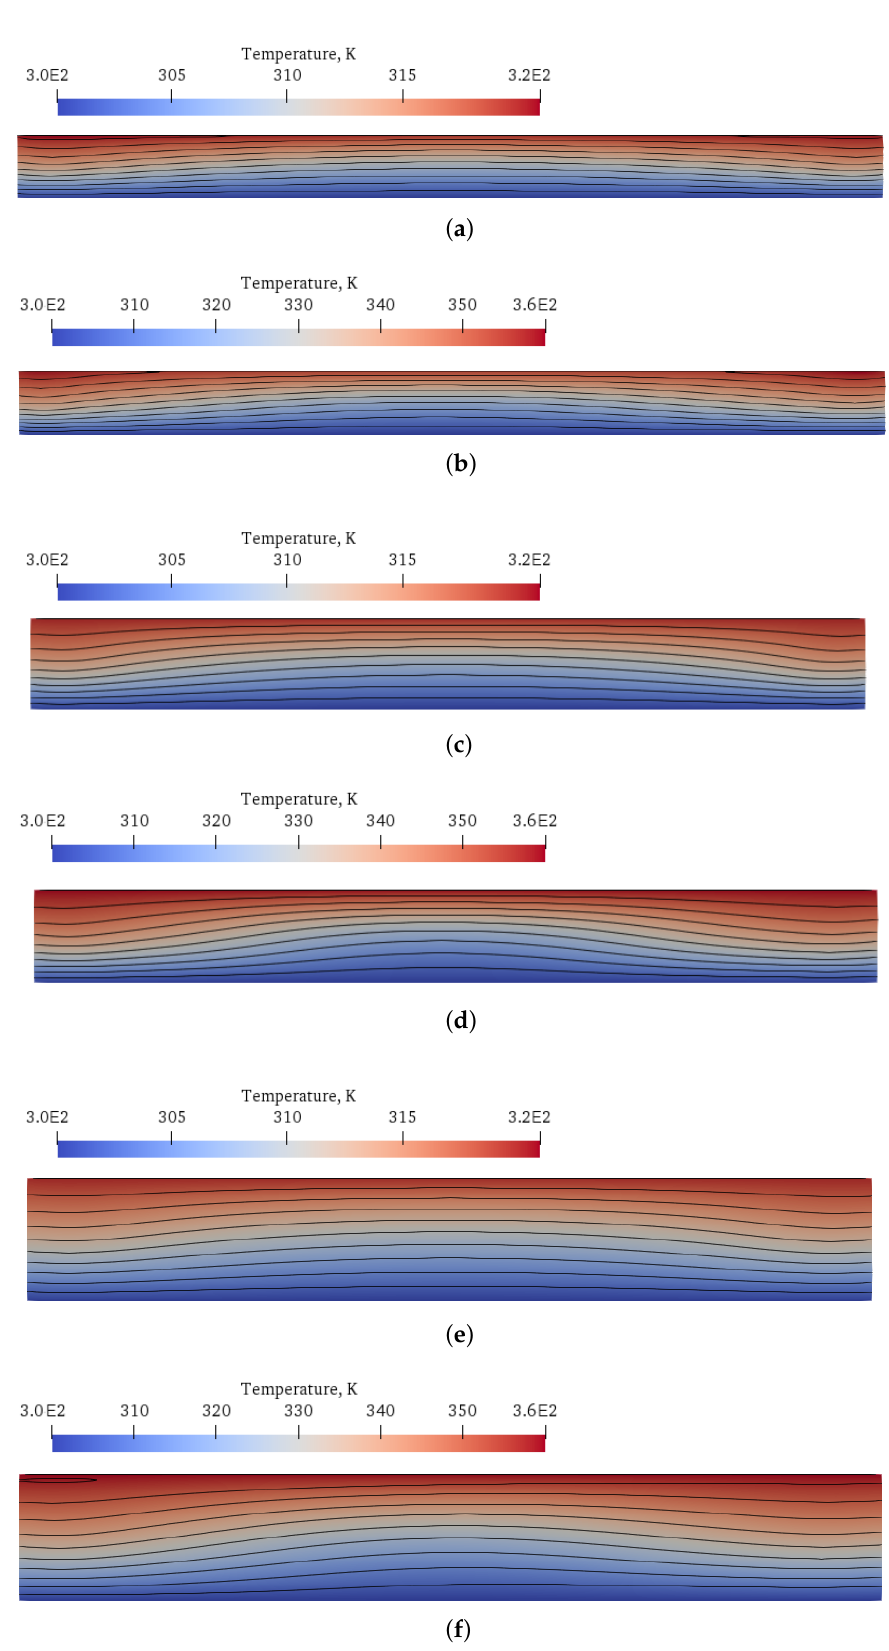
Figure 13. Mean temperature and isotherms for the non-isothermal cases. ( a ) Case 1B*, ∆ T = 20 K, f = 20 kHz. ( b ) Case 1C*, ∆ T = 60 K, f = 20 kHz. ( c ) Case 2B ∆ T = 20 K, f = 40 kHz. ( d ) Case 2C ∆ T = 60 K, f = 40 kHz. ( e ) Case 3B, ∆ T = 20 K, f = 80 kHz. ( f ) Case 3C, ∆ T = 60 K, f = 80